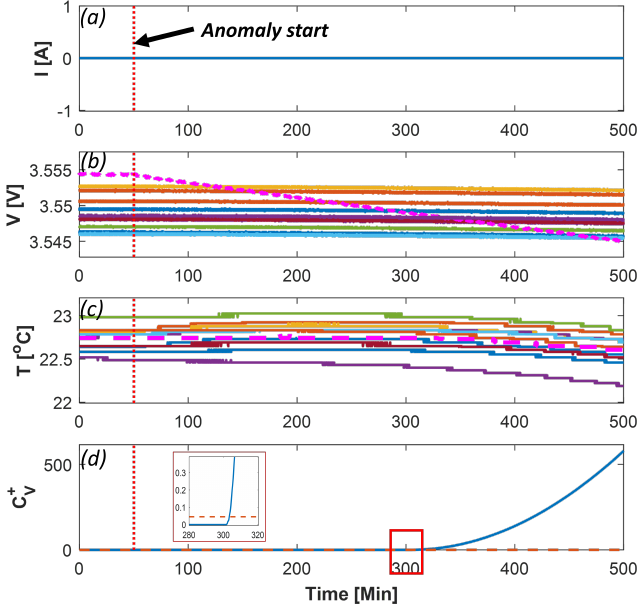
Figure 8. Detection using PCA method on experimental data with ESC in cell 10 initiated at 50 min (vertical, dotted): ( a ) Pack current; ( b ) Voltages of 11 cells (cell 10, dashed); ( c ) Temperatures of 11 cells (cell 10, dashed); ( d ) C + with its threshold V